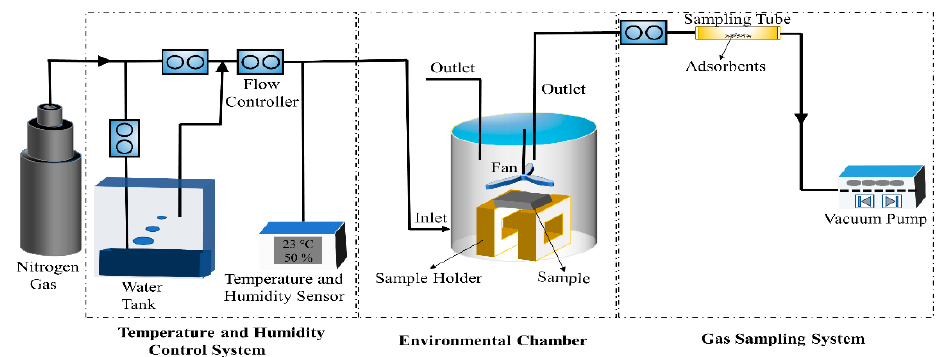
Figure 4. The schematic representation of the 15 L environmental chamber.